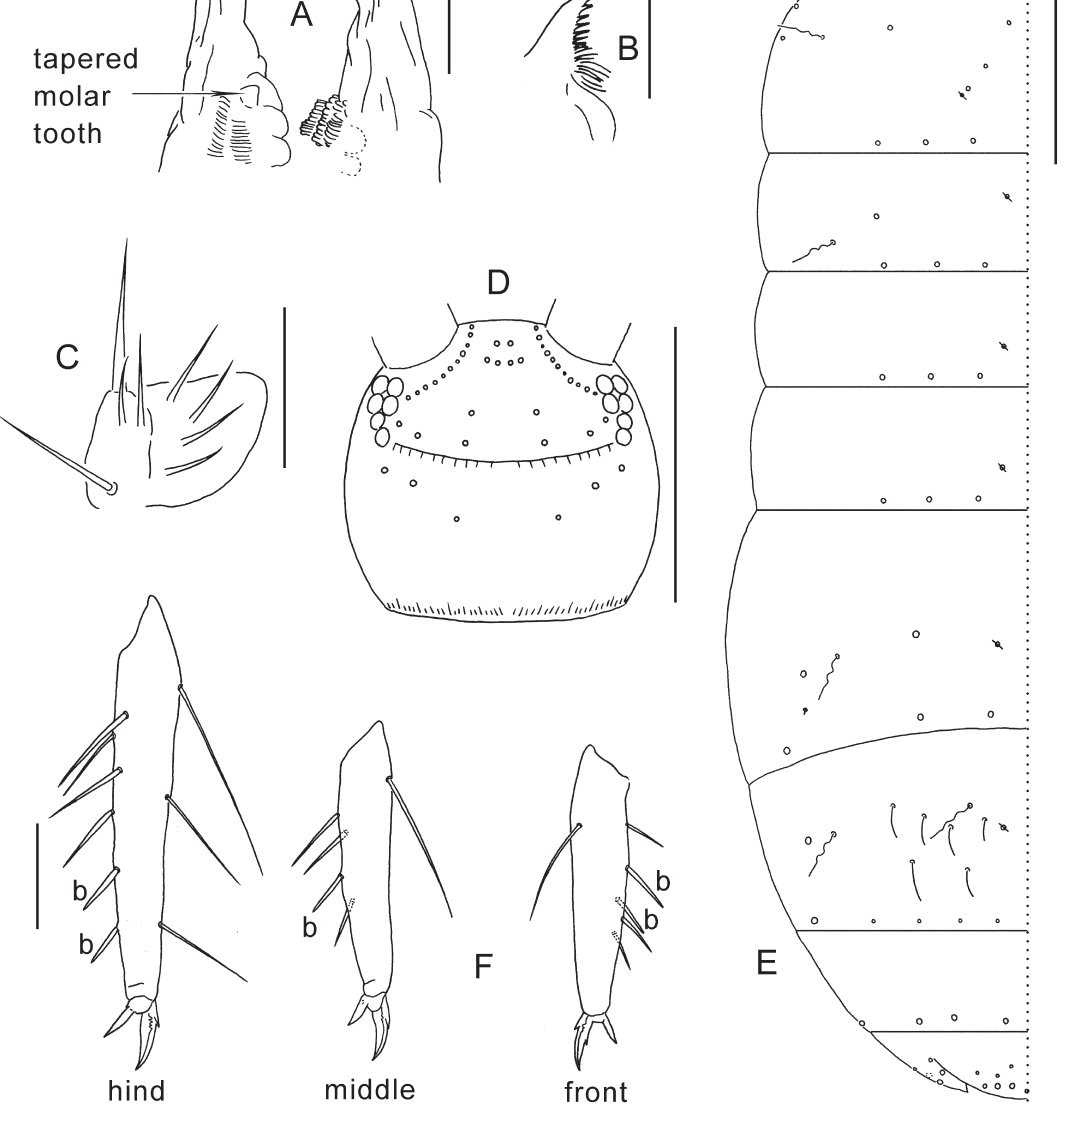
Fig. 4. Tomocerina annamitica sp. nov. A . Apical half of mandibular head (dorsal view). B . Lamella 5 of maxillary head (dorsal view). C . Maxillary outer lobe (ventral view). D . Cephalic dorsal chaetotaxy. E . Dorsal chaetotaxy of Th. II–Abd. VI. F . Left tibiotarsi (lateral view, b = blunt inner chaeta). Scale bars: A, C = 50 μm; B = 10 μm; D, E = 250 μm; F = 100